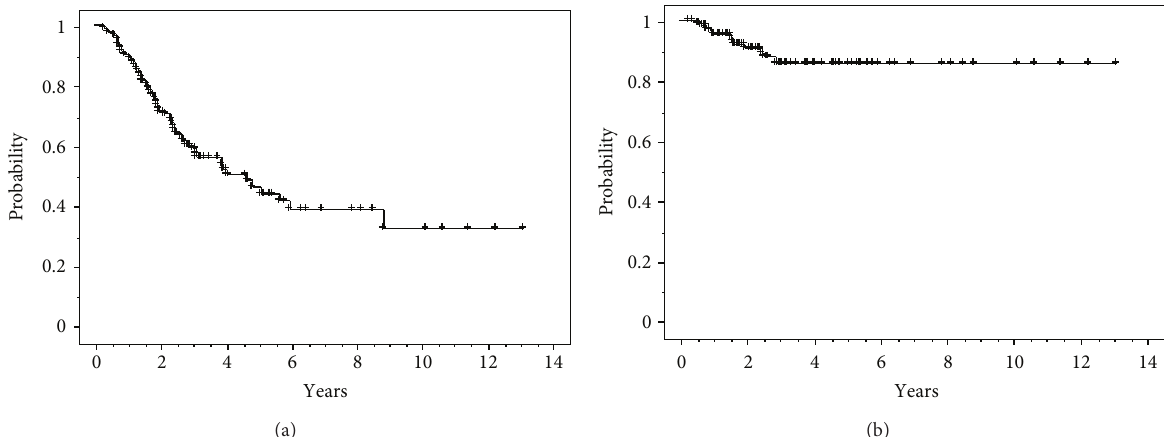
Figure 1: (a) Overall survival rate ( 𝑛 = 91 ). (b) Local control rate for lung metastases ( 𝑛 = 116 ).